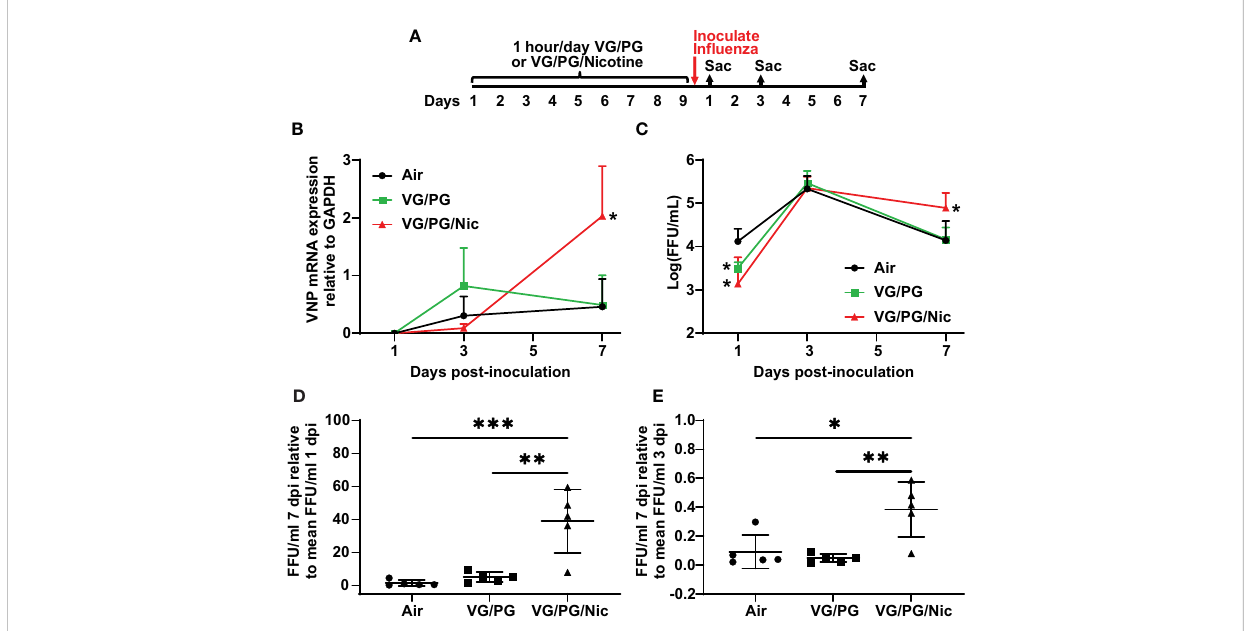
FIGURE 5 Nicotine-containing e-cigarette aerosol exposure impairs clearance of in fl uenza virus. (A) Timeline of the experiment with separate groups of mice sacri fi ced 1-, 3-, and 7-days post-inoculation (dpi) with in fl uenza. (B) Viral nucleoprotein (VNP) mRNA expression in the lung homogenate signi fi cantly increased (p < 0.05) from 3 dpi to 7 dpi in mice exposed to aerosolized nicotine (VG/PG/Nic) but not in those exposed to the aerosolized carrier VG/PG or to air. The presented data was normalized to GAPDH mRNA expression. * P < 0.05, mixed effects model with Tukey ’ s multiple comparisons test at each timepoint, comparing VNP/GAPDH expression between the three groups. (C) The concentration of viral particles, presented in foci-forming units/milliliter (FFU/ml), in the lung homogenate peaked at 3 dpi and decreased at 7 dpi in mice exposed to the aerosolized carrier VG/PG or to air but remained signi fi cantly elevated at 7 dpi in those exposed to aerosolized nicotine (VG/PG/Nic). * P < 0.05, mixed effects model with Tukey ’ s multiple comparisons test at each timepoint, comparing FFU/ml between the three groups. (D, E) The absolute FFU/ml counted at 7 dpi as a ratio to the mean FFU/ml at 1 dpi (D) and at 3 dpi (E) . * P < 0.05, ** P < 0.01, *** P < 0.001, 1-way ANOVA with Tukey ’ s multiple comparisons test. Each data point represents the mean and standard deviation from fi ve mice in (B, C) , and represents one mouse in (D, E)